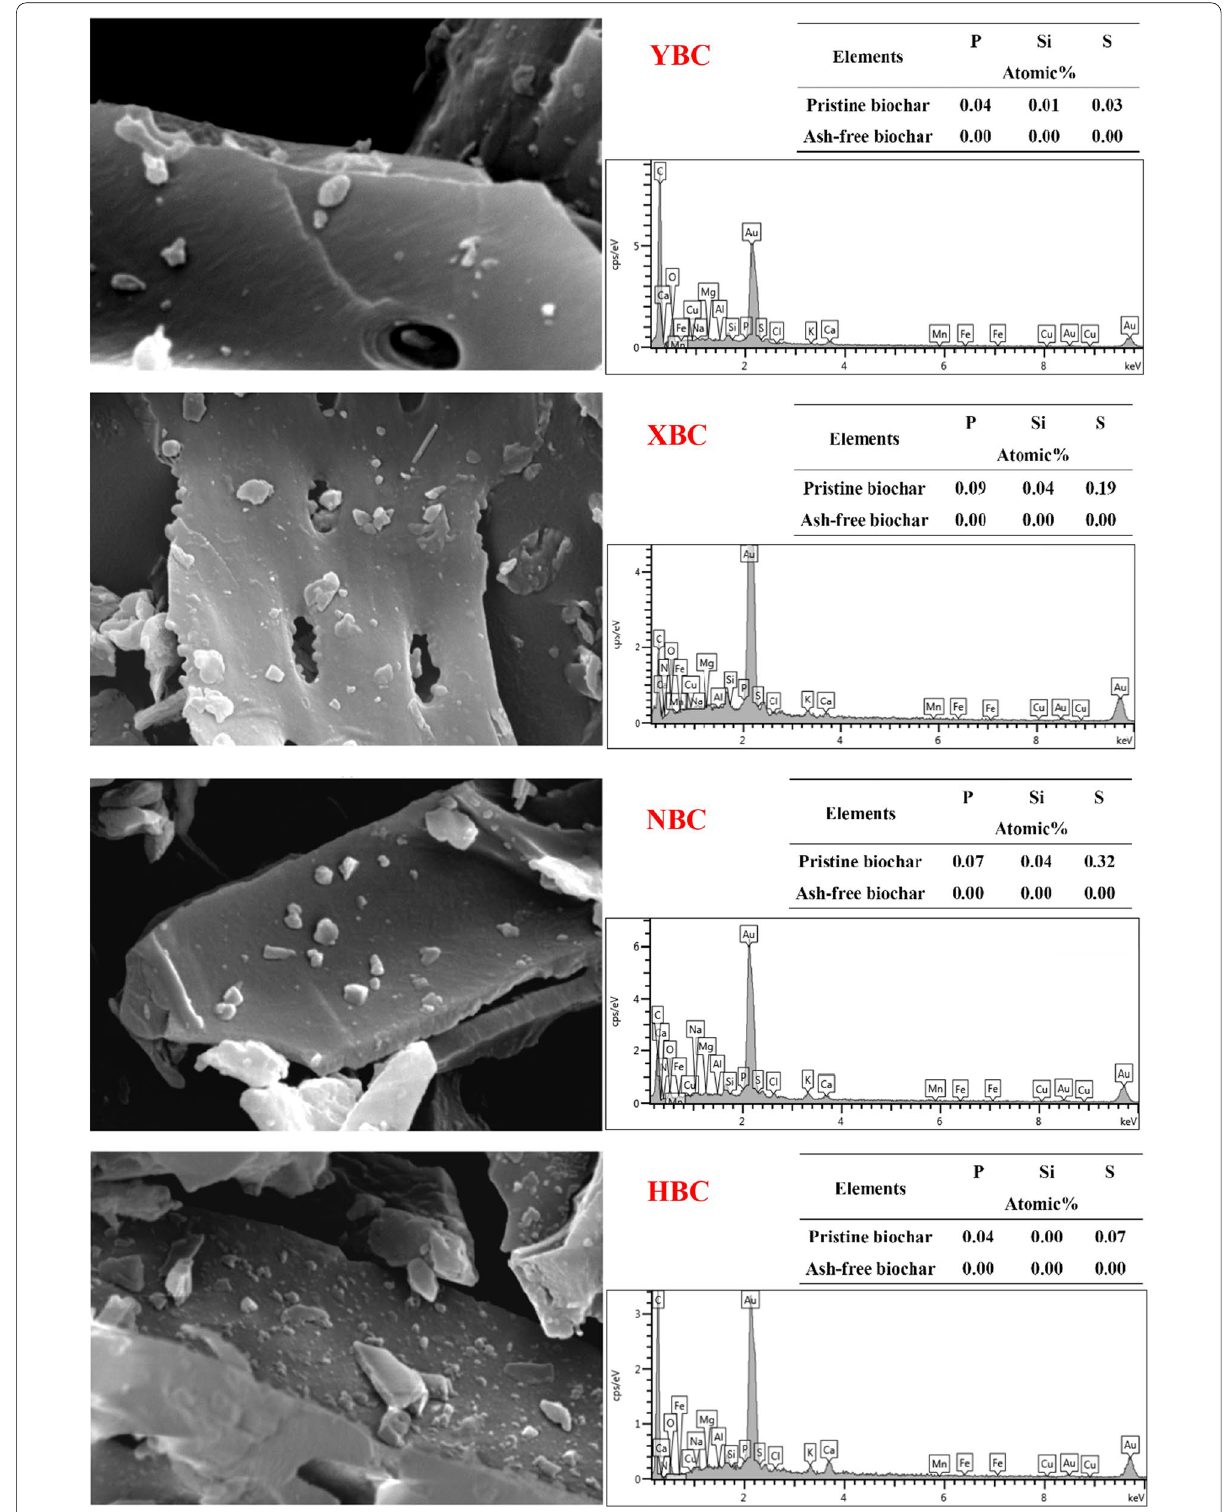
Fig. 5 Scanning electron microscopic images and elemental spectrum of Au-coated materials of four biochars,